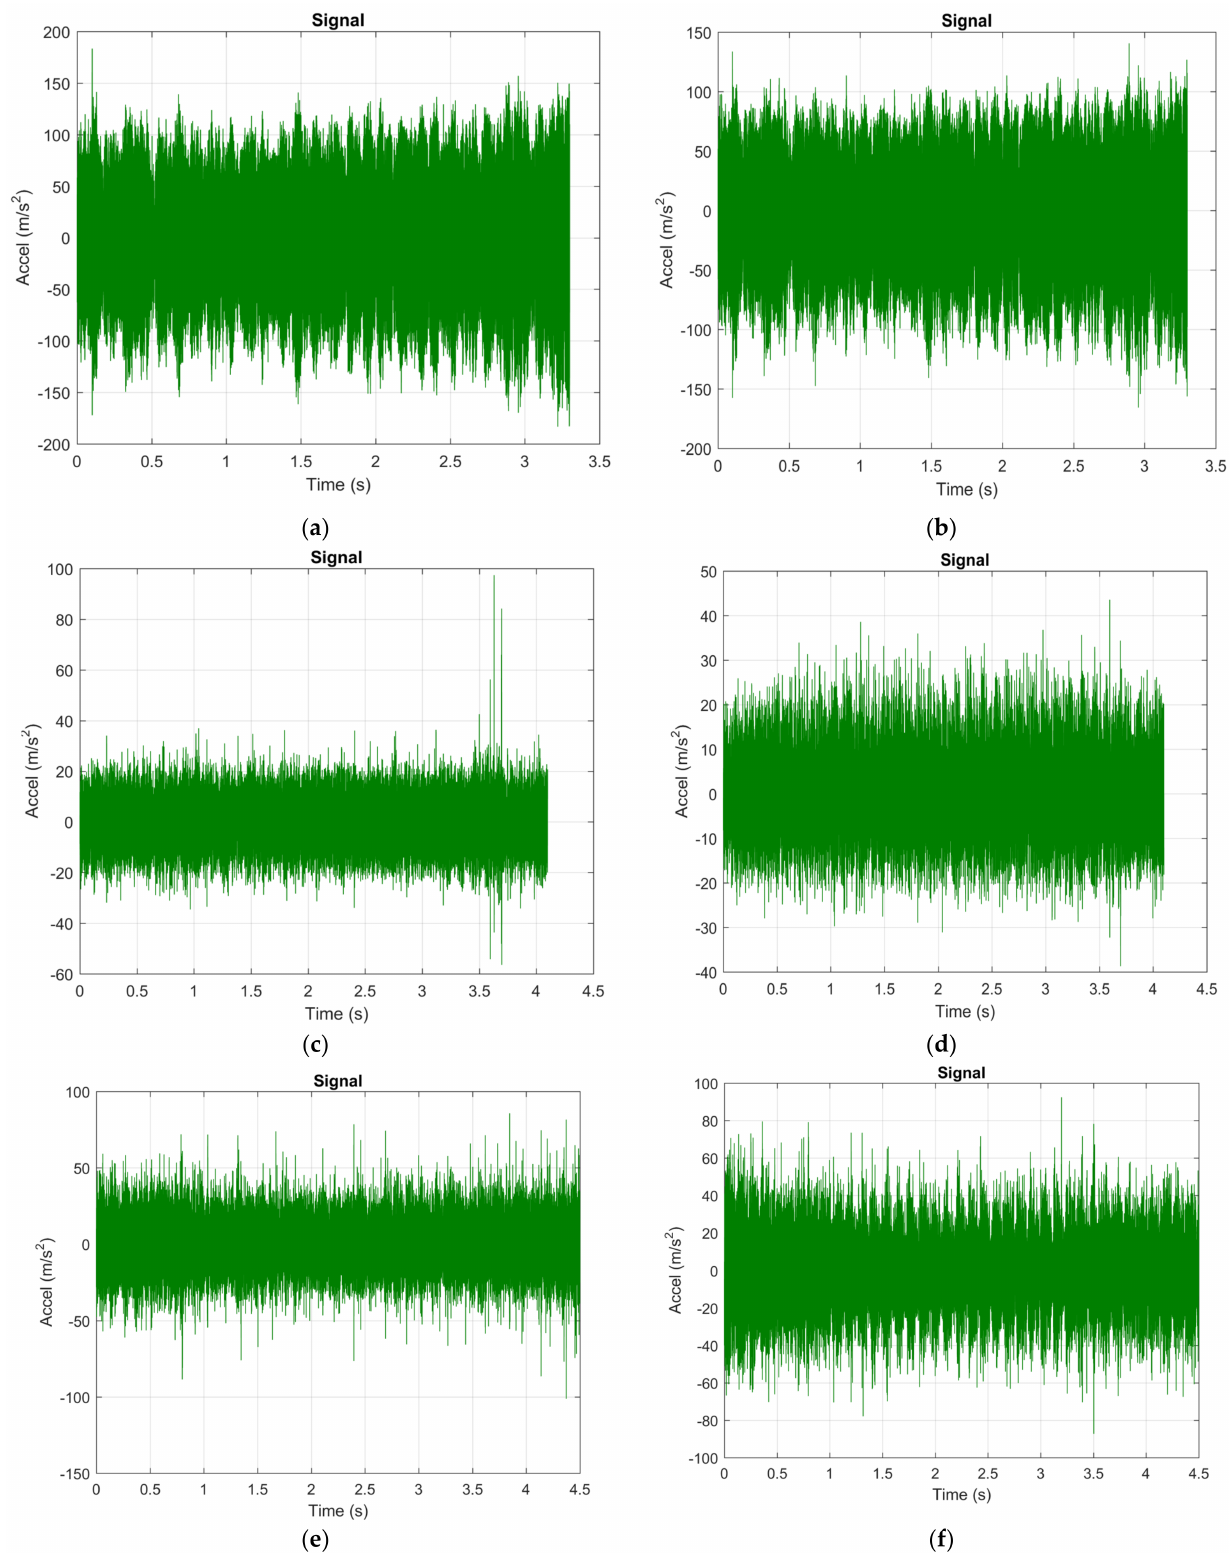
Figure 9. Acceleration of vibrations recorded during machining: ( a ) in the Z direction in the case of machining with cutting tool T01; ( b ) in the Y direction in the case of machining with a T01 cutting tool; ( c ) in the Z direction in the case of machining with a cutting tool T02; ( d ) in the Y direction in the case of machining with a cutting tool in variant T02; ( e ) in the Z direction in the case of machining with a T03 cutting tool; ( f ) in the Y direction in the case of machining with a T03 cutting